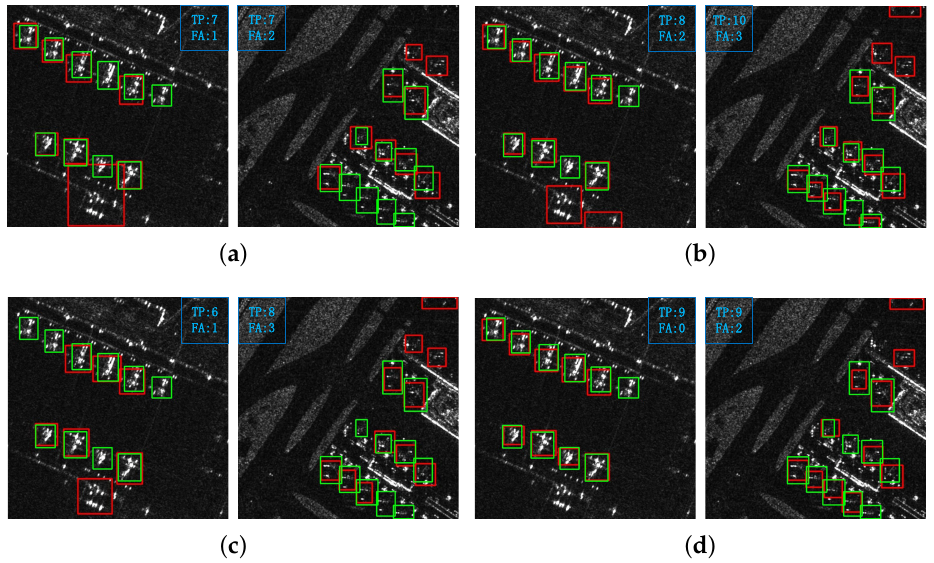
Figure 12. The detection results reported in Table 4. The red boxes represent the detection results and the green boxes represent the ground truth. We count the evaluation results in blue boxes. TP means accurately predicted targets and FA means false alarms. ( a ) +Dens [32]. ( b ) +RB. ( c ) +LDM(+Dens). ( d ) LDM.